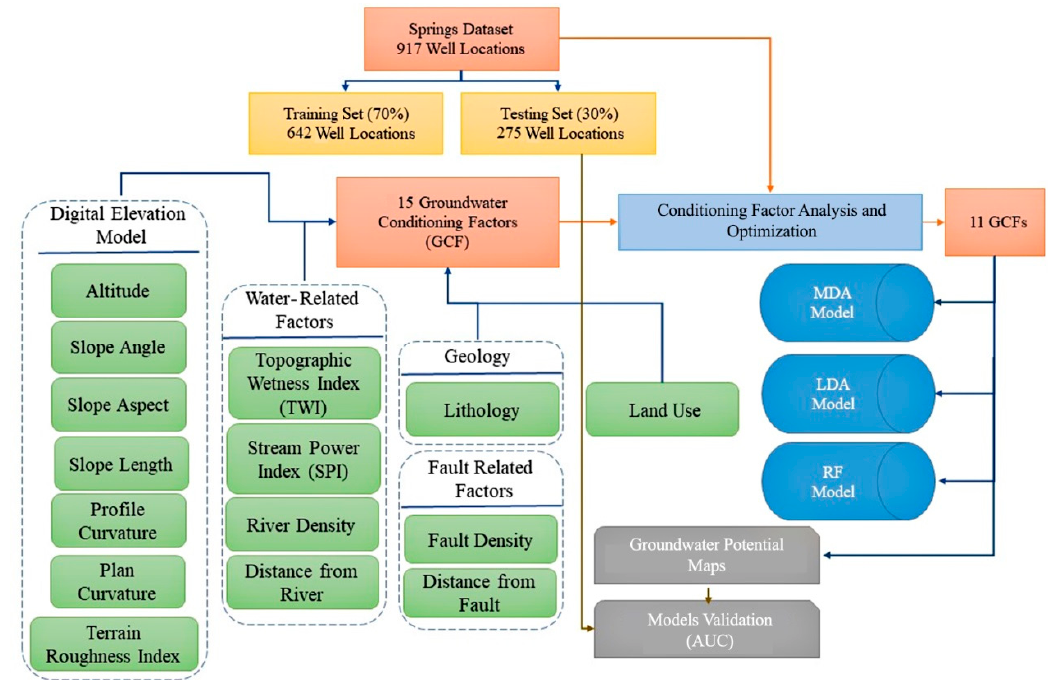
Figure 4. Methodological flow chart.